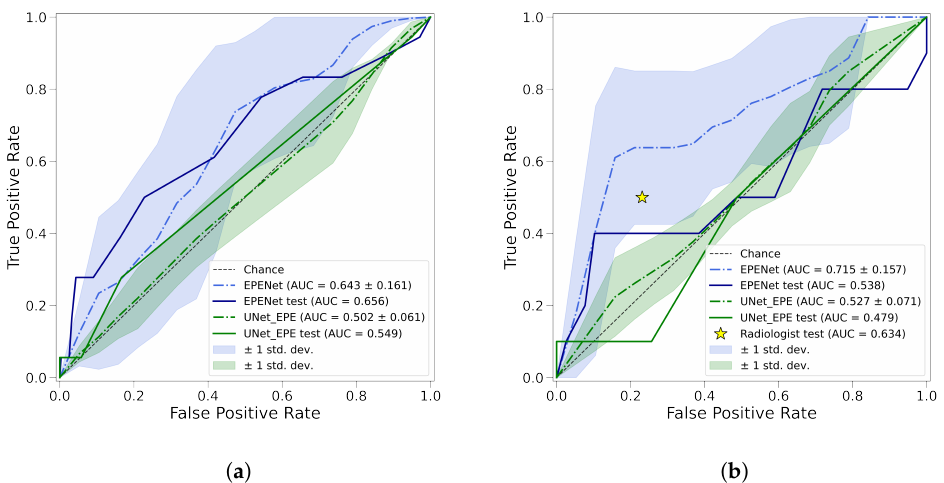
Figure 5. Receiver operating characteristic curves based on performance metrics at the sextant-level ( a ) and patient-level ( b ). Dashed lines are the mean performance over the five cross-validation folds and the shaded regions represent one standard deviation around the average. Solid lines are the ROC results in the test set. EPENet model is shown in blue, UNet_EPE model is green. In panel ( b ), the star marker represents radiologists performance on the test